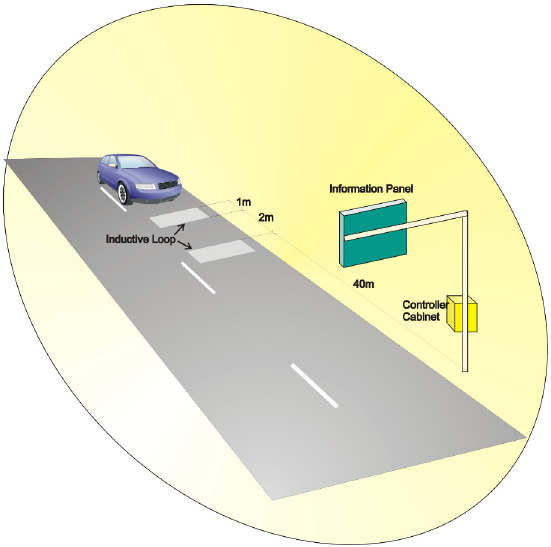
Figure 8. Possible position in the field of the component parts of the informing and monitoring